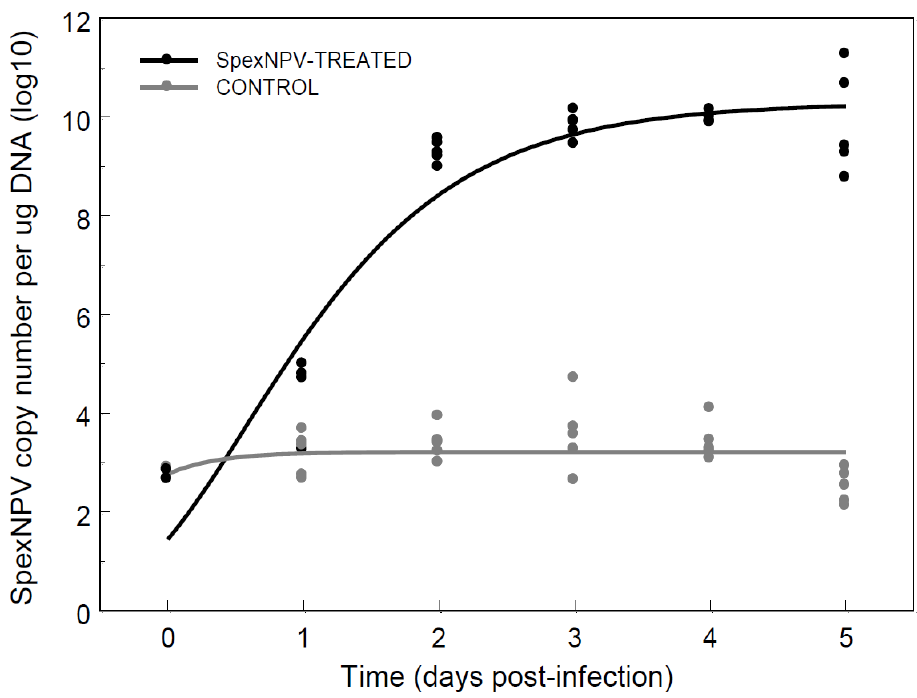
Figure 3. Dynamics of SpexNPV genome replication following ingestion of 10 4 OBs (treated) and dH 2 O (control). The lines are the fitted Gompertz curves (see text for details). Arguably, a better way to describe the SpexNPV dynamics of infected larvae is to fit a Gompertz function to the data: f (x) = a × exp(– b × exp(− k × x)). When this non-linear growth function was fitted to the infection data, the parameter estimates (+ S.E.) for a , b and k were as follows: Control larvae: a = 3.213 + 0.135, b = 0.149 + 0.156, k = 2.849 + 0.843; SpexNPV-treated larvae: a = 10.286 + 0.325, b = 1.963 + 0.371, k = 1.144 + 0.193. Only the asymptote parameter, a , was significantly different